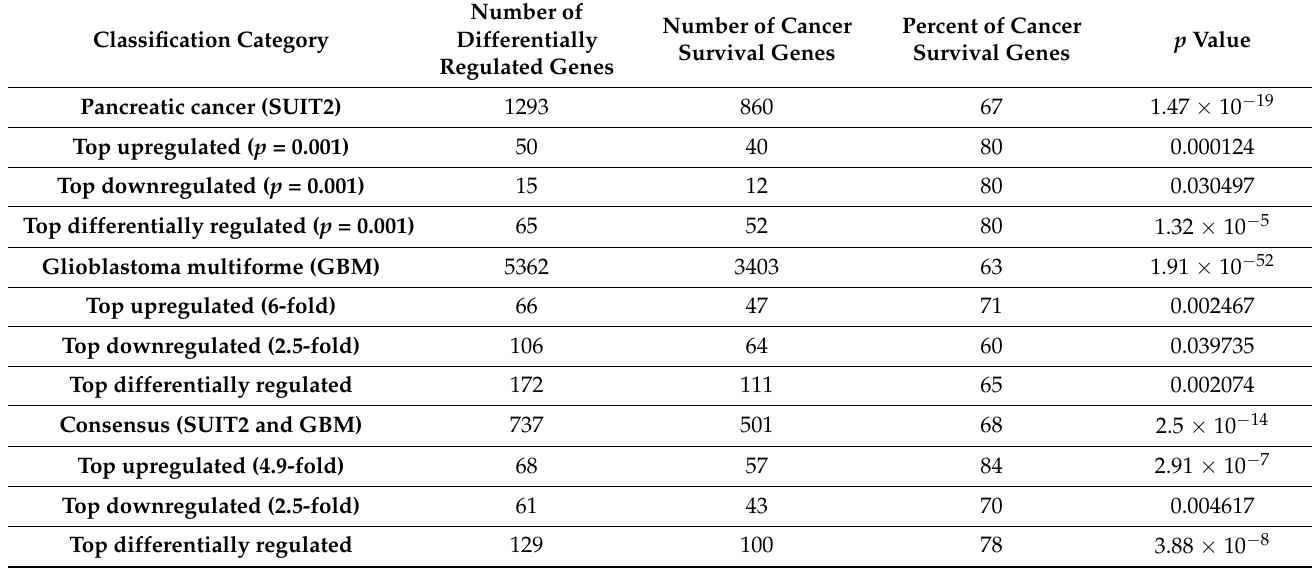
Table 1. P-bi-TAT treatment alters expression of a large number of human cancer survival genes. p values were estimated using the hypergeometric distribution